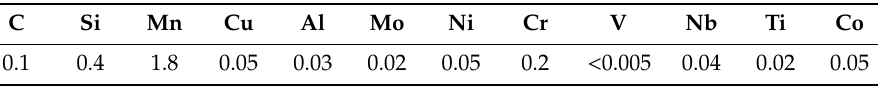
Table 1. Chemical composition of the micro-alloyed mild steel, all data in wt% [6].